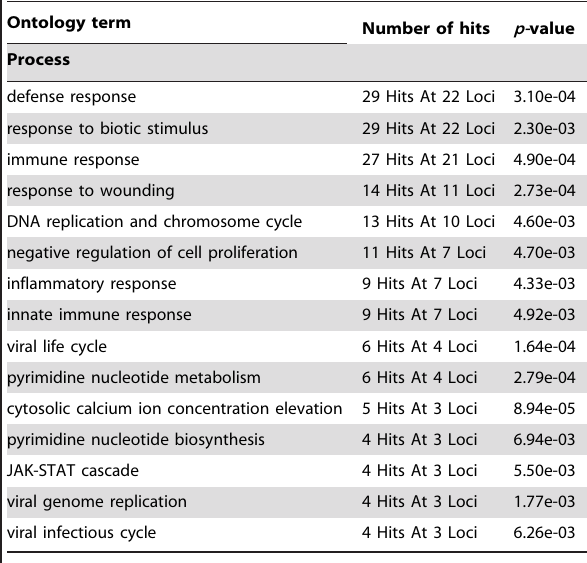
Table 1. Gene ontology analysis results (Process domain) for SNPs mapping on genes that correlate with pathogen